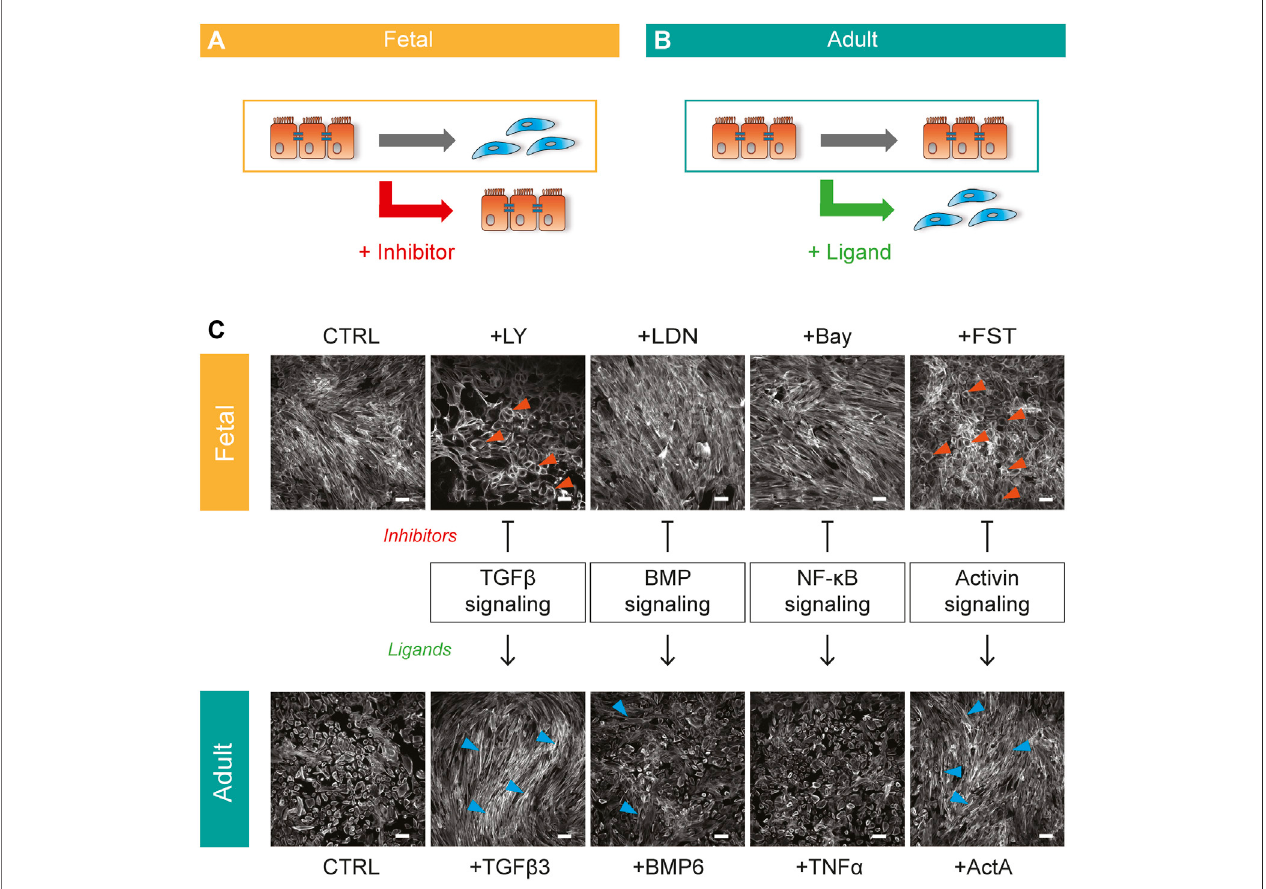
FIGURE1| Bi-directionalcellculturemodeltounravelepiMTregulatingpathways (A) SchematicrepresentationofspontaneousfetalepiMTasaplatformtoidentify inhibitors of epiMT. (B) Schematic representation of adult EPDCs as a model to identify inducers of epiMT. (C) Combined bi-directional model of human fetal (top) and adult (bottom) EPDCs cultured for 5 days with multiple inhibitor-ligand combinations to assess pathway involvement in epiMT. Phalloidin staining shows the epithelial (orange arrows) and mesenchymal (blue arrows) phenotype. Inhibitors: LY-2157299 (LY), LDN212854 (LDN), Bay 11-7085 (Bay), Follistatin (FST), Ligands: Transforming growth factor beta 3(TGF β 3), bone morphogeneticprotein 6(BMP6), tumor necrosisfactor alpha (TNF α ),Activin A(ActA). Representativefor n (cid:1) 3. Scale bar: 100 µM.